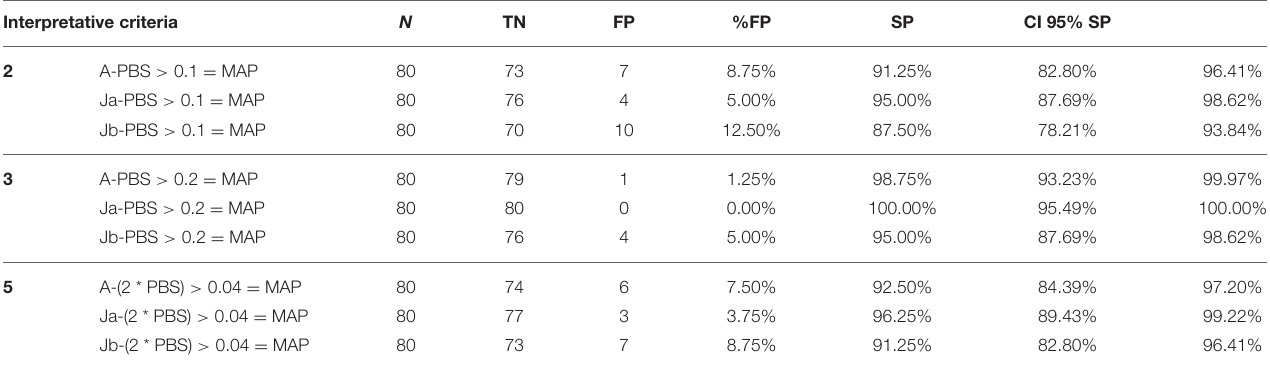
TABLE 3 | Specificity values obtained in the 3rd group of animals, adopting the 2nd, 3rd, and 5th interpretative criteria of the IFN- γ test. Interpretative criteria N TN FP %FP SP CI 95%